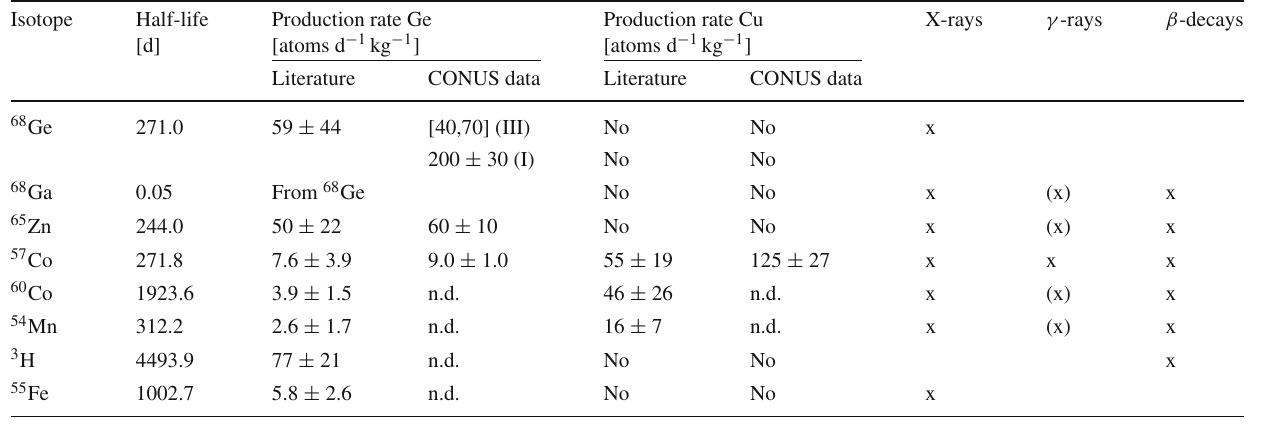
CONUS background data production rates are derived. The other cases are marked by n.d. (no data). The last column summarizes the expected decay signatures with a significant branching ratio. The applicable radi- ation is marked with x, and (x) refers to a line background above the